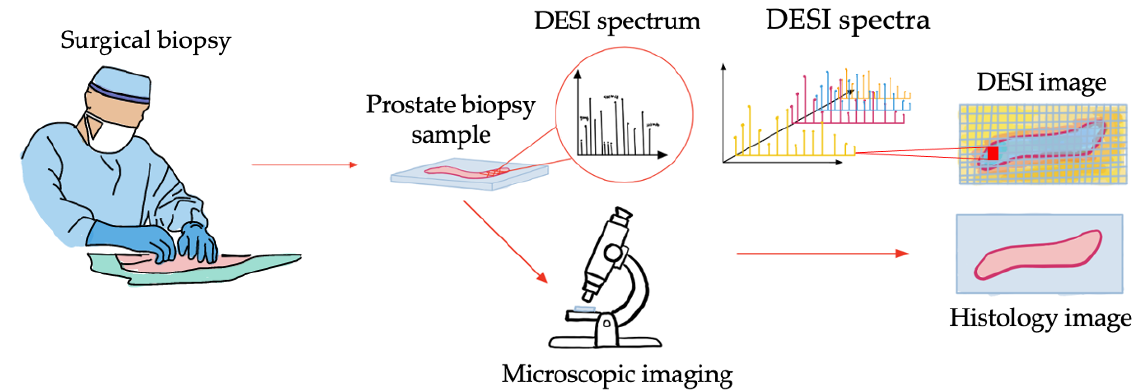
Figure 1. Visual representation of 3D DESI images in a surgical workflow.